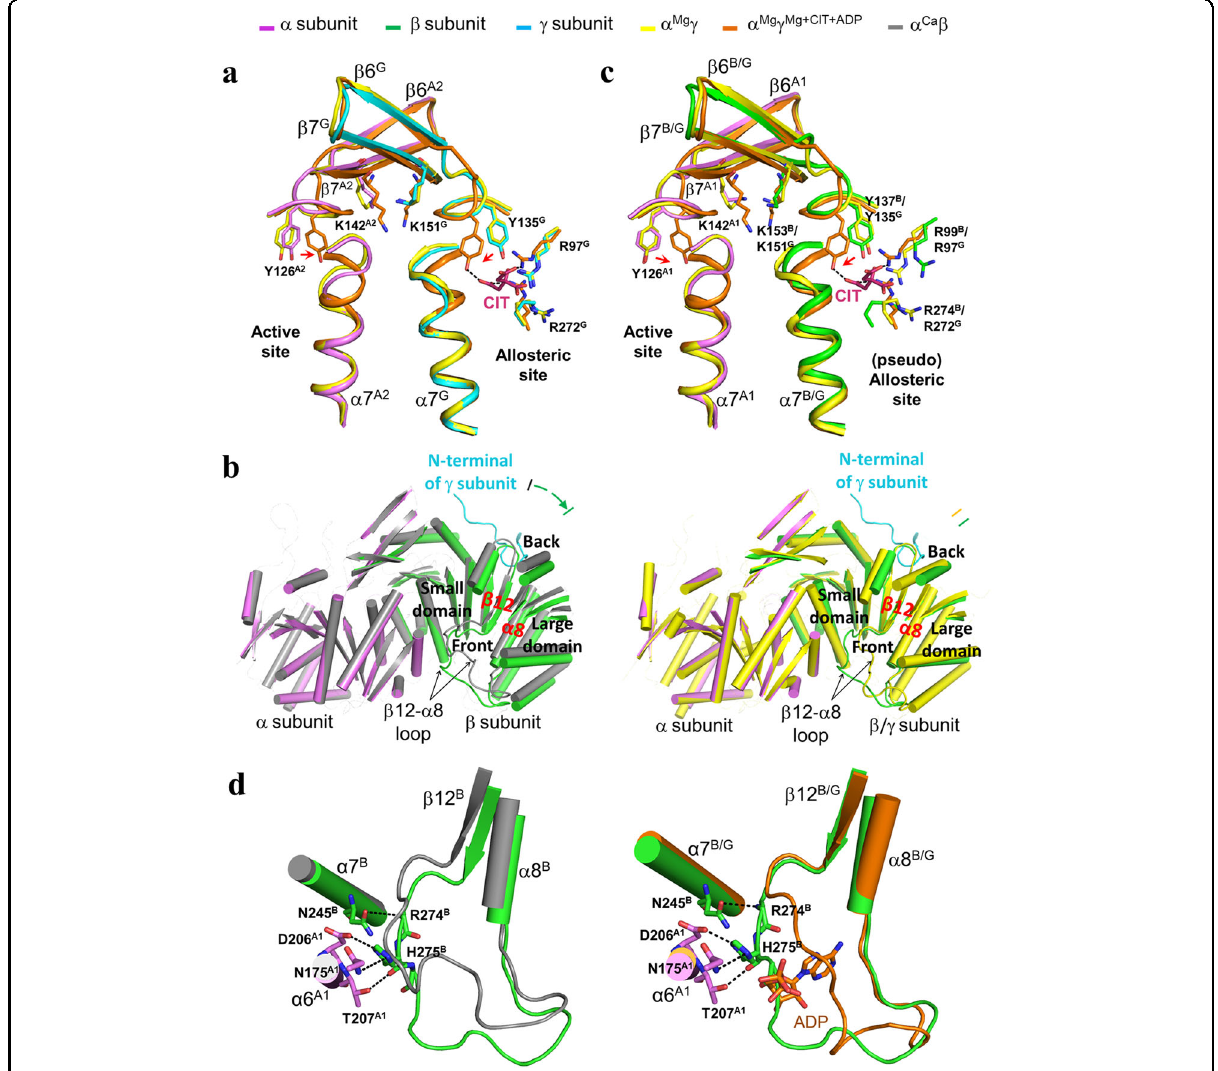
Fig. 3 Structural comparisons of the αβ and αγ heterodimers in the apo β -mutant HsIDH3 and in the isolated forms. a Comparison of the αγ heterodimer in the heterooctamer of HsIDH3 and in the isolated forms at the heterodimer interface. The color coding of the subunits and structures is shown above. The key residues at the active site (Tyr126 A2 ), the allosteric site (Arg97 G , Tyr135 G , and Arg272 G ), and the heterodimer interface (Lys151 G and Lys142 A2 ) assume similar conformations as those in the inactive α Mg γ structure (PDB code: 5GRH) rather than those in the active α Mg γ Mg + CIT + ADP structure (PDB code: 5GRF). b Comparison of the overall conformation of the αβ heterodimer in the heterooctamer of HsIDH3 with that of the isolated α Ca β heterodimer (PDB code: 6KDE) (in gray, left panel) and α Mg γ heterodimer (in yellow, right panel). The αβ heterodimer assumes an open overall conformation similar to that of the isolated α Mg γ heterodimer rather than the compact conformation of the isolated α Ca β heterodimer. For clarity, only the α helices and β strands are shown, and the loops are omitted except the β 12- β 8 loops of the β and γ subunits. The N-terminal of the γ subunit from another heterotetramer is also shown. c Comparison of the αβ heterodimer in the heterooctamer of HsIDH3 with the isolated α Mg γ heterodimer and α Mg γ Mg + CIT + ADP heterodimer. The key residues at the active site (Tyr126 A1 ), the pseudo allosteric site (Arg99 B , Tyr137 B , and Arg274 B ), and the heterodimer interface (Lys153 B and Lys142 A1 ) assume similar conformations as those in the inactive α Mg γ structure rather than those in the active α Mg γ Mg + CIT + ADP structure. d The β 12 B - β 8 B loop of the β subunit in the heterooctamer of HsIDH3 exhibits some conformational differences from that in the isolated α Ca β heterodimer but still occupies the ADP-binding site in the α Mg γ Mg + CIT + ADP structure. The hydrogen-bonding interactions of the β 12 B - β 8 B loop with the α 7 B and α 6 A1 helices are indicated with dashed